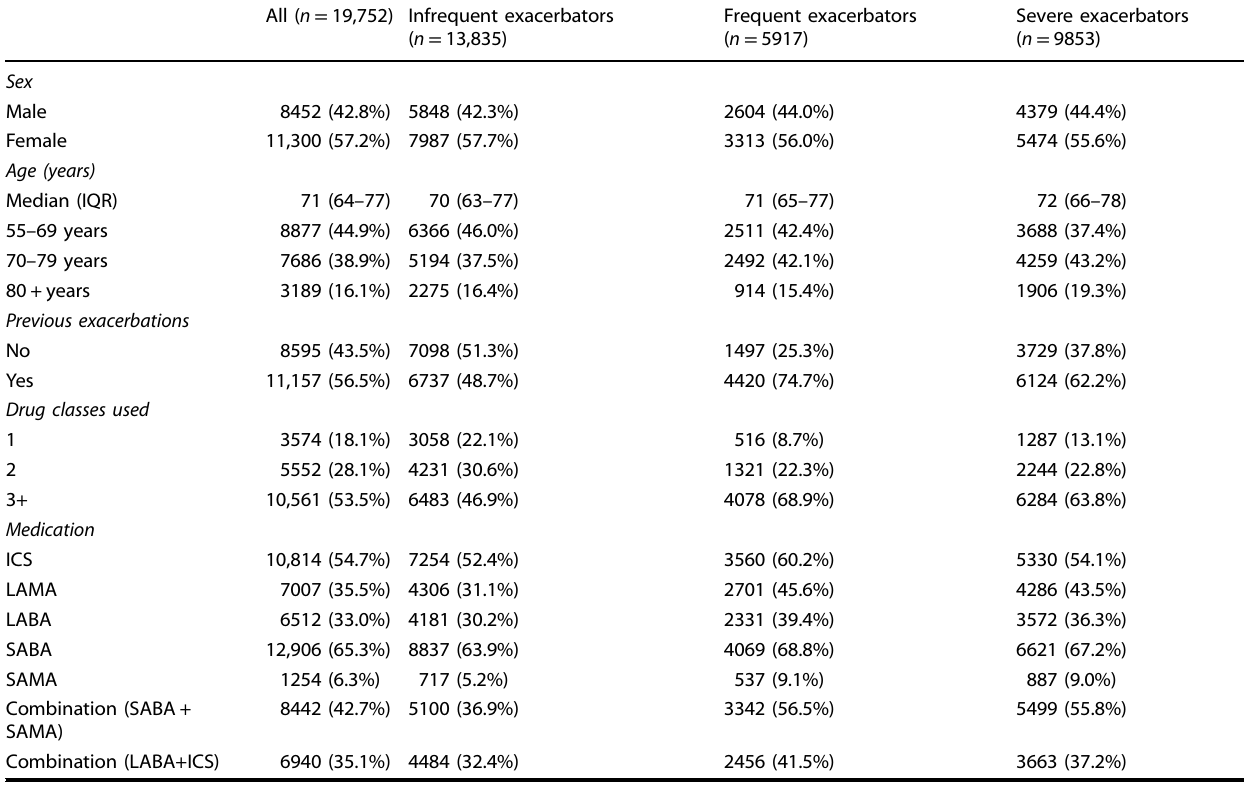
Table 1. Baseline characteristics of the study population (31 December 2003)